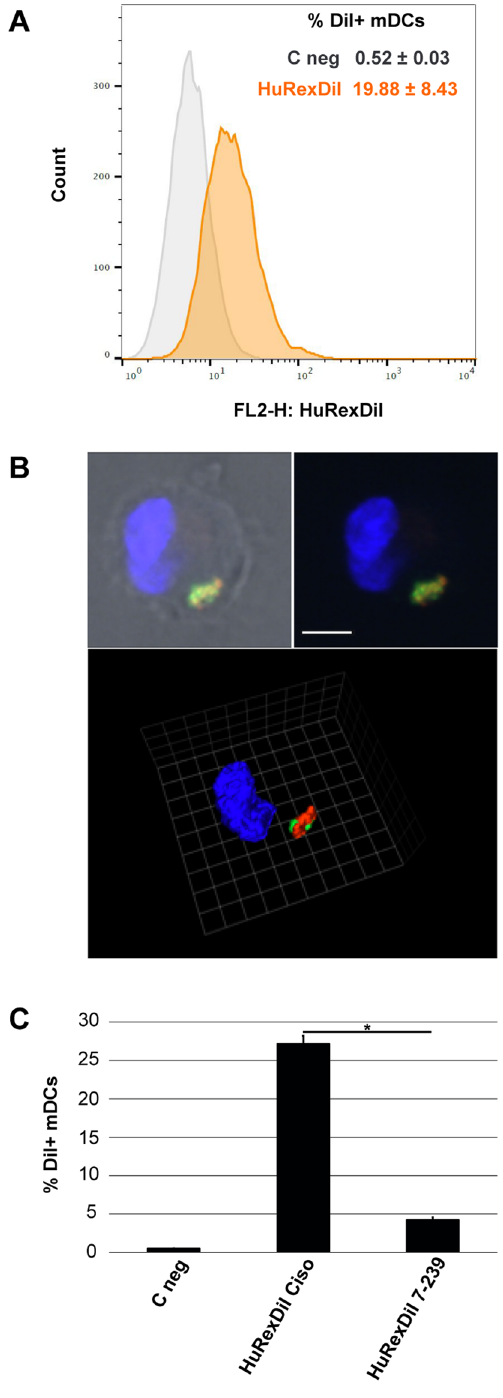
Figure 4. Siglec-1 dependent capture of human reticulocyte-derived exosomes by mature dendritic cells. ( A ) Flow cytometry analysis of HuRex DiI capture by mDCs. (B) Confocal microscopy co-localization of HuRex DiI (in red) and VLP HIV-Gag-eGFP (in green) in mDCs (nuclei stained with DAPI). Top: z-plane showing fluorescence and bright field (scale bar 5 μ m); Bottom: 3D reconstruction of z-planes (reference scale unit 2,48 μ m). (C) Inhibition of HuRex DiI capture by mDCs by blocking of Siglec-1 with α -Siglec-1 mAb. mDCs not treated with antibodies nor with HuRex DiI were incubated in parallel (C neg). Data show mean values and SD from 2 donors. T-test P <